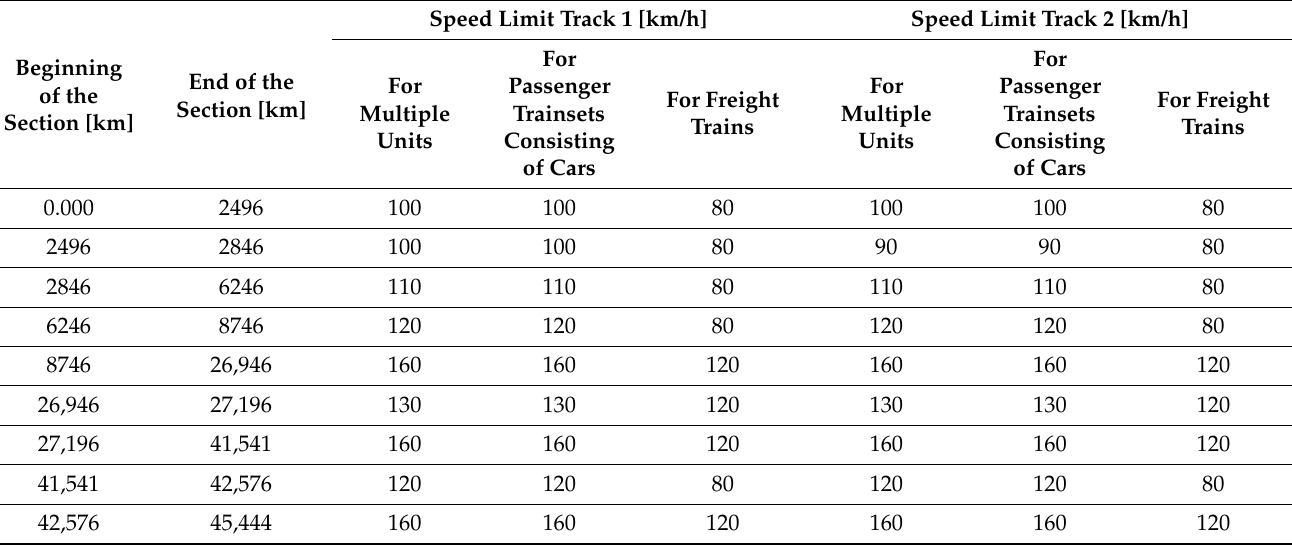
Table 2. Maximum permissible speeds for train traffic on the line under consideration